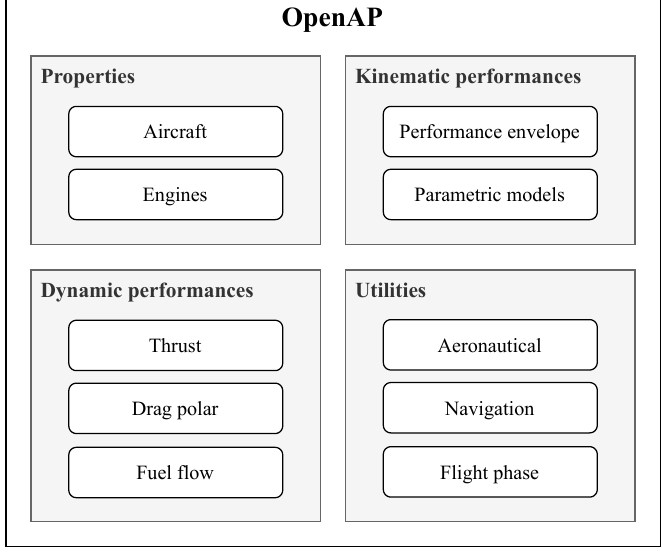
Figure 1. The structure of